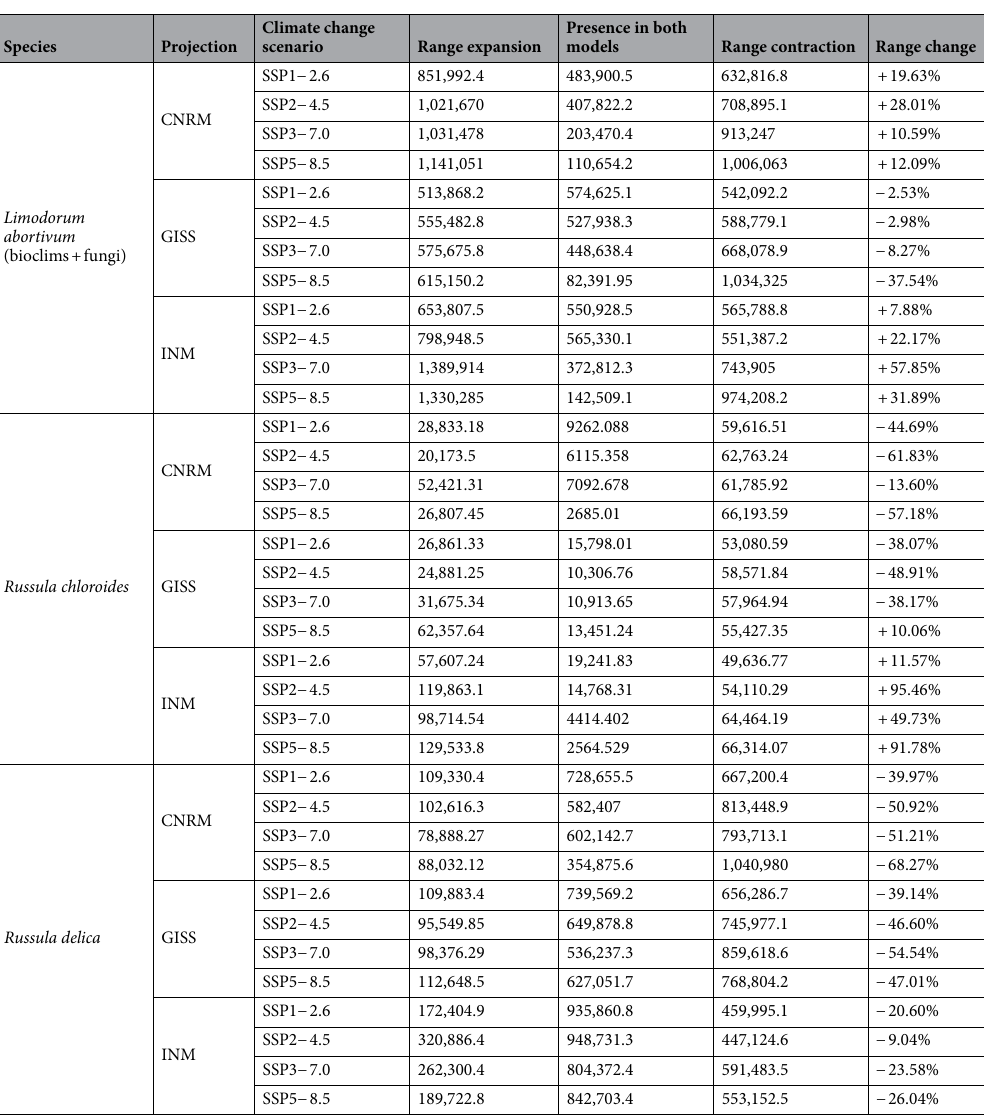
Table 3. Changes in the coverage of suitable niches of L. abortivum , its fungal symbionts and